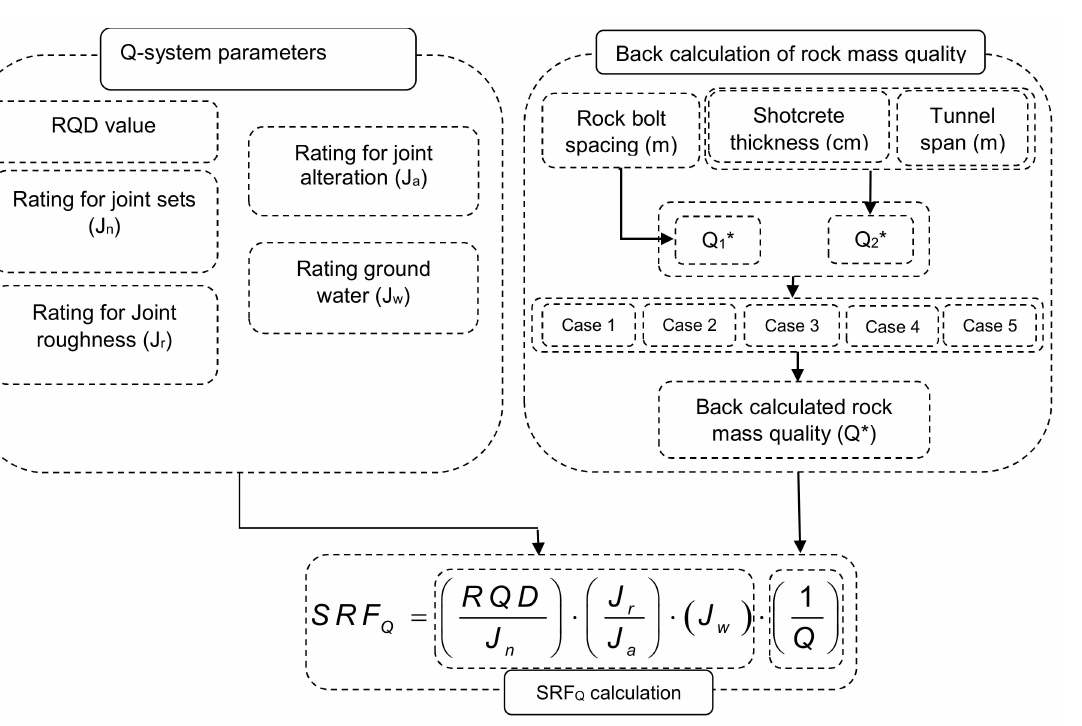
Figure 9. Procedure for calculating the stress reduction factor, while considering the five cases listed in Table 6 (modified after